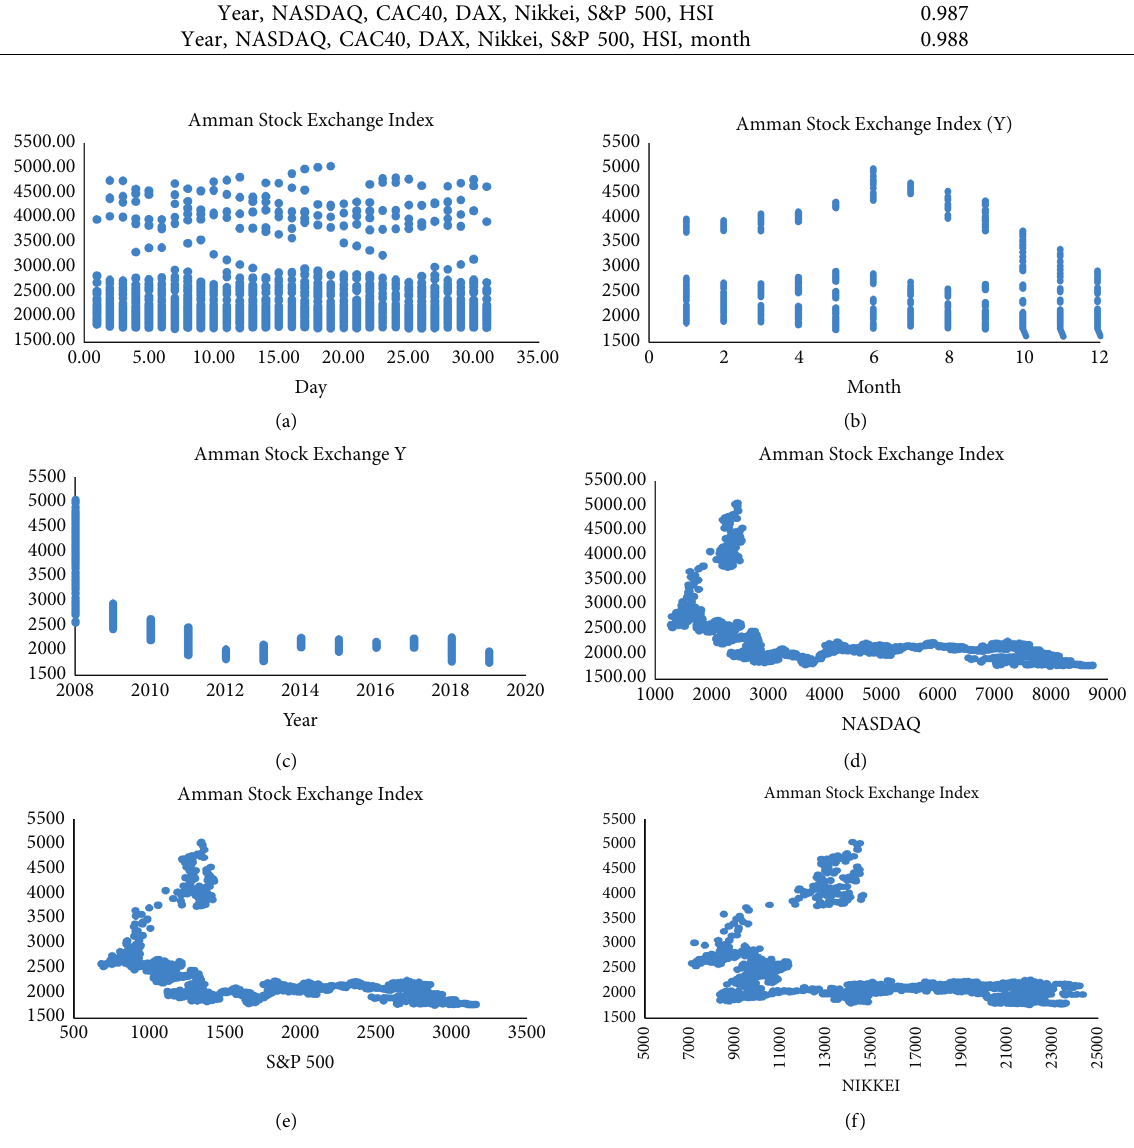
Figure 3: Relationship between ASEI and (a) day, (b) month, (c) year, (d) NASDQ, (e) S&P 500, and (f)